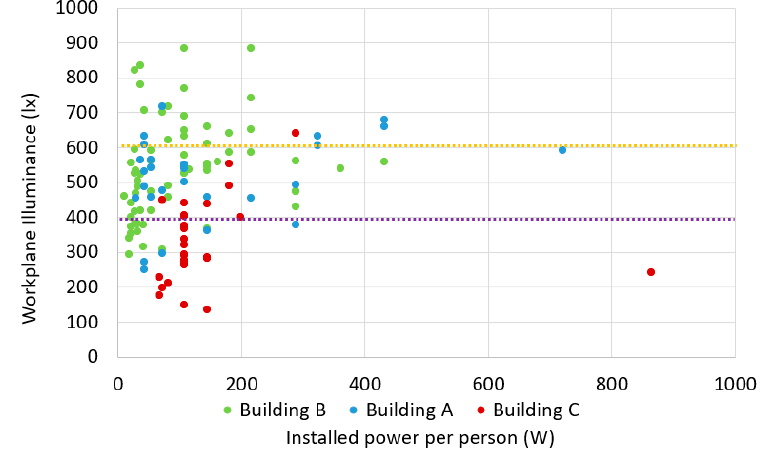
Figure 16. Illuminance measurements vs. installed power per person.